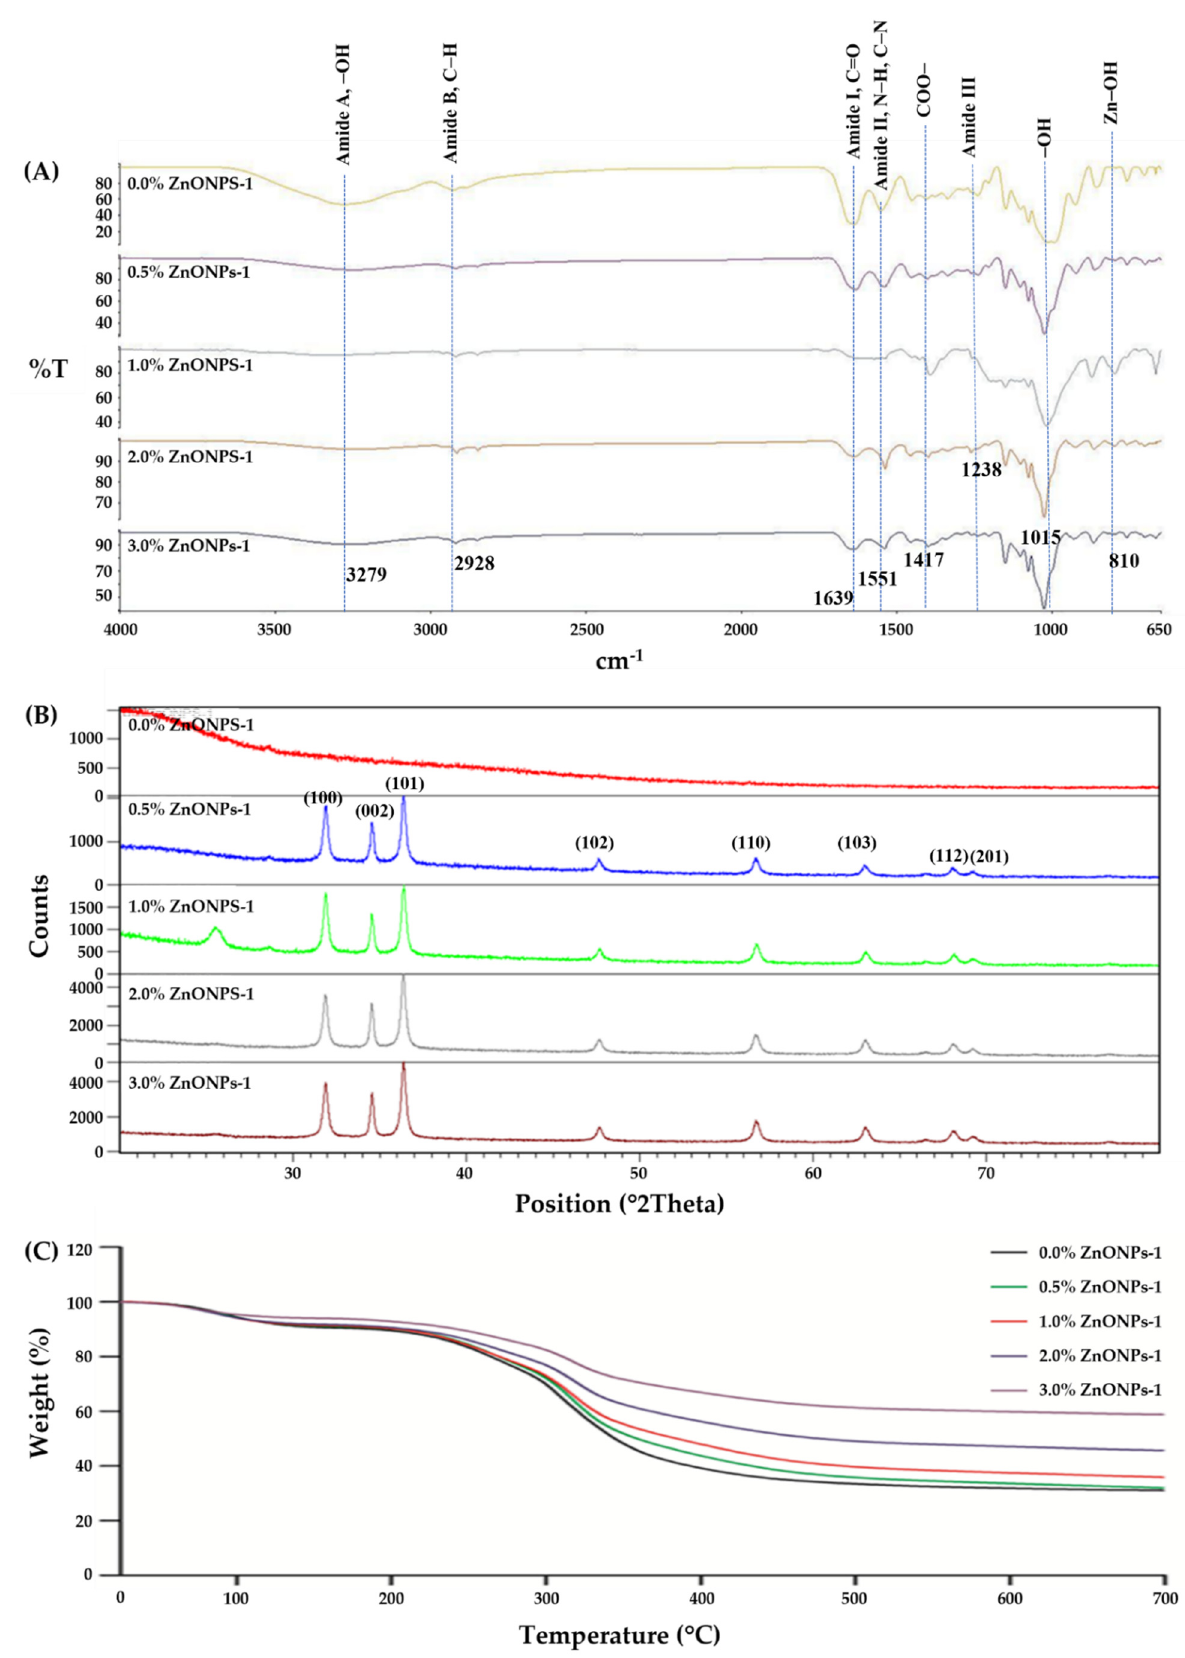
Figure 4. FT-IR spectra ( A ), XRD pattern ( B ), and TGA curves ( C ) of RS–G films incorporated with different concentrations of ZnONPs. Numbers denote the ZnONPs concentrations (%, w / v ).